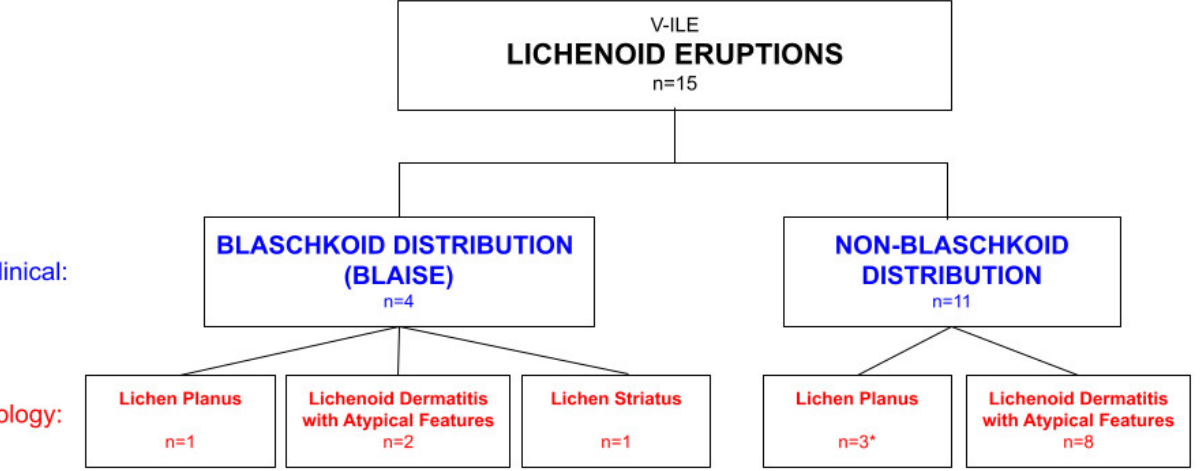
Figure 3. Classification of 15 patients with COVID-19 vaccine-induced lichenoid eruptions based on the clinical distribution of the eruption and pathology